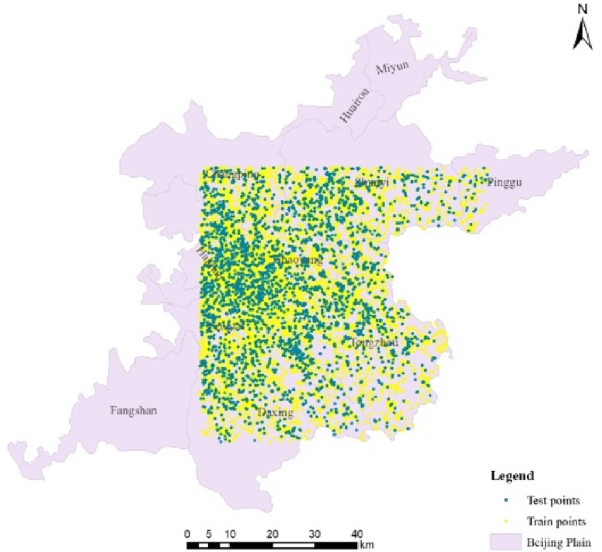
Figure 4. The distribution of the train and test data (the administra- tive map is from the Beijing Institute of Geo-Environment Monitor-